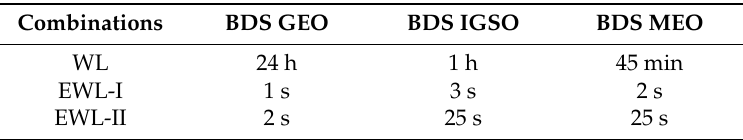
Table 9. Minimum time needed for reaching 100% fixing rate. The results of the WL combination are computed based on the HMW combination. The results of the EWL-I and EWL-II combinations are computed based on Equations (3) and (5), respectively.